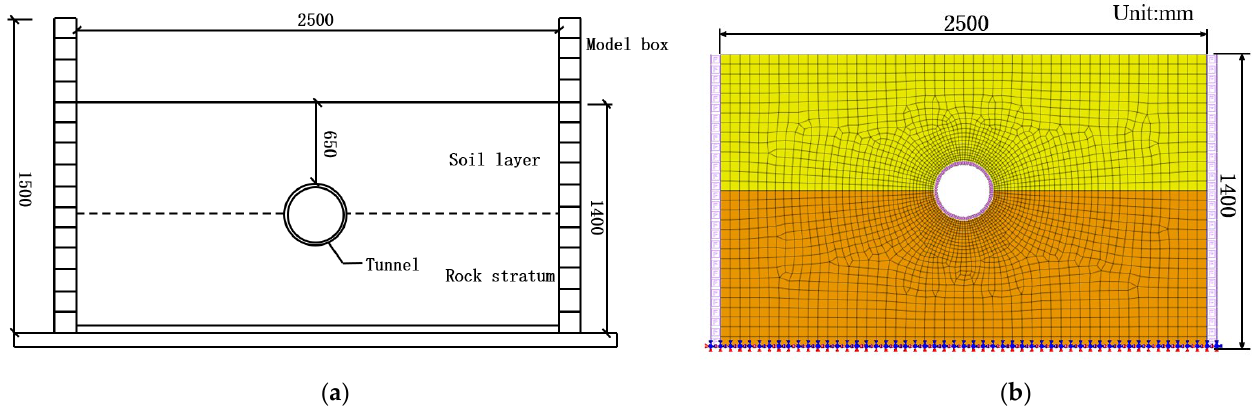
Figure 5. Schematic Diagram of Shaking Table Test and Numerical Simulation: ( a ) Shaking table test; ( b ) Finite element model.